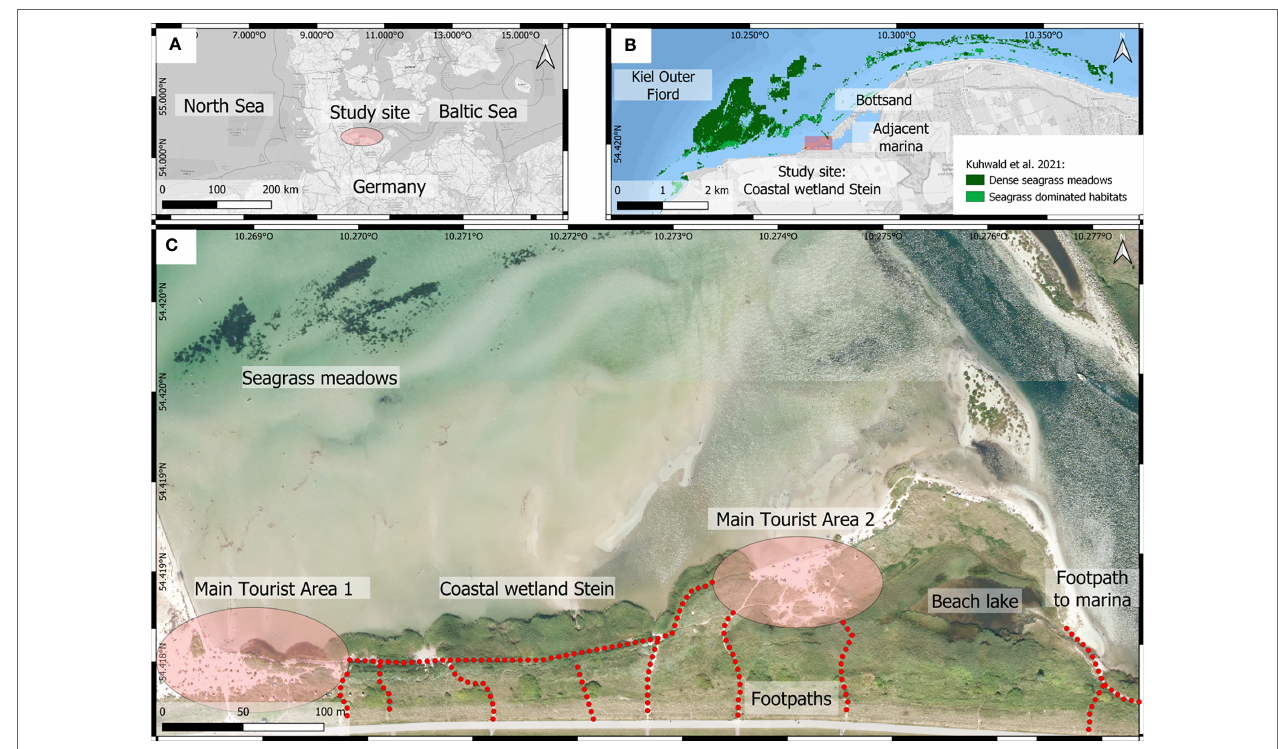
FIGURE 1 | (A) The coastal wetland Stein is situated in northern Germany at the outer Kiel Fjord, Baltic Sea (Background map: Open Street Map). (B) Large seagrass meadows are located north-west of the study site (Data is derived from Sentinel satellite and cut off at 4 m water depth, provided by Kuhwald et al. (2021). Adjacent to the coastal wetland is the spit formation Bottsand, a nature protection area, as well as a marina. (C) Several footpaths cross the coastal wetland at Stein. The main footpath connects the tourist areas from east to west (The aerial image from 2019 was chosen as background image as it was taken during summer, showing the main tourist areas, data provided by the State Office for Surveying and Geoinformation